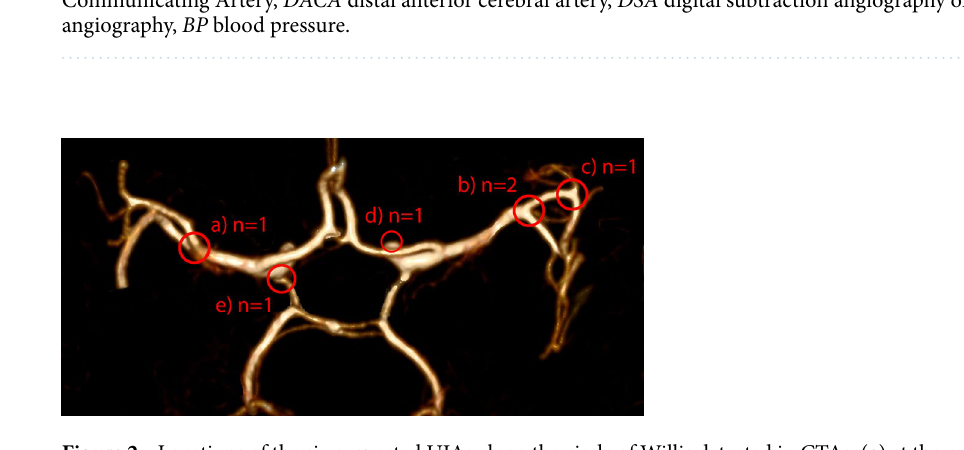
Figure 2. Locations of the six suspected UIAs along the circle of Willis detected in CTAs: ( a ) at the main bifurcation of left MCA, ( b ) at the main bifurcation of right MCA, ( c ) at the M2/3 bifurcation of the right MCA, ( d ) at the right ICA-ophthalmic segment, ( e ) at the left ICA- posterior communicating